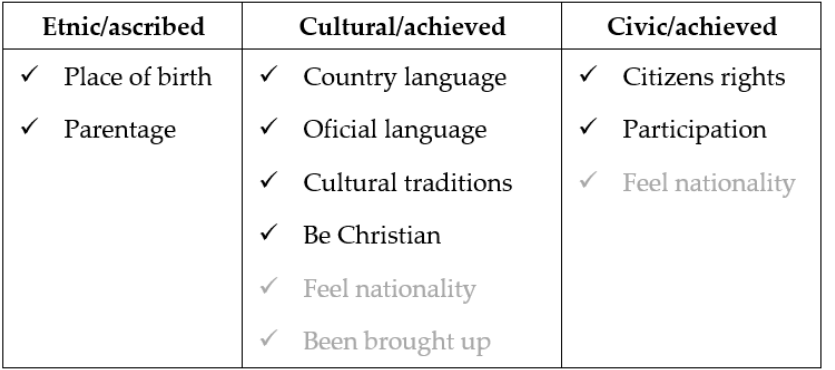
Figure 2. Identity classification by relying on citizen understanding of the most important charac- teristics to be German/Spanish/Italian/Greek/Portuguese 2 . Authors’ own elaboration from Euroba- rometer 73.3.